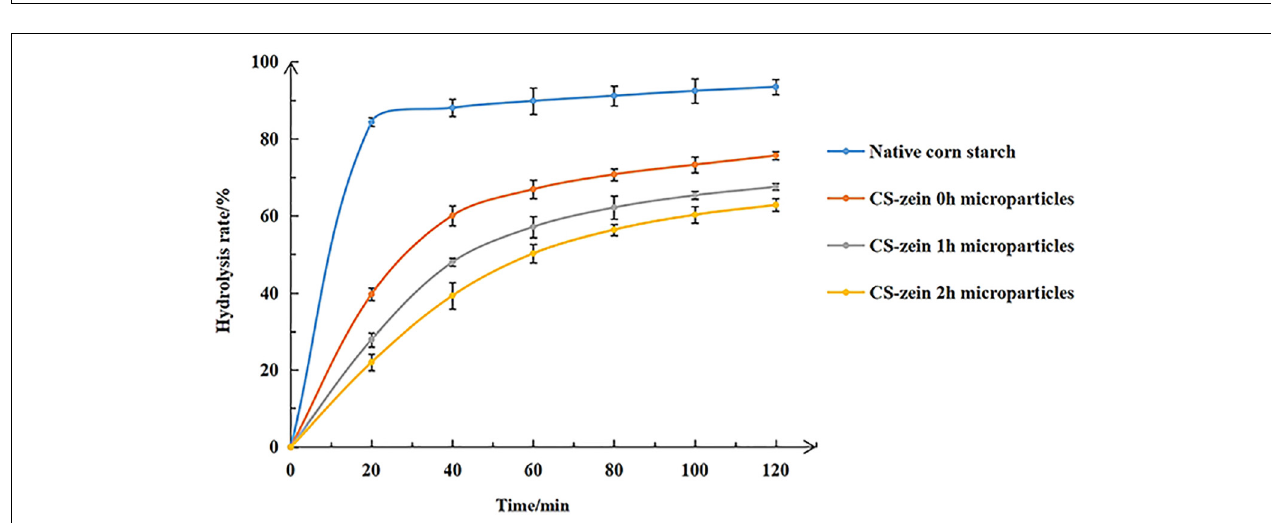
FIGURE 9 | In vitro hydrolysis profiles of native corn starch and core-shell starch/zein microparticles crosslinked by TGase for different times (0, 1, and 2 h).